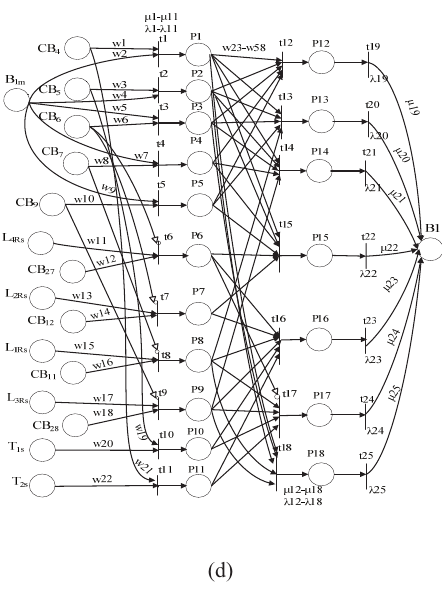
Fig. 4 Improved fault diagnosis model of power system based on AFPN (cid:726) (a) bus A (b) Line L (c) transform T (d) bus